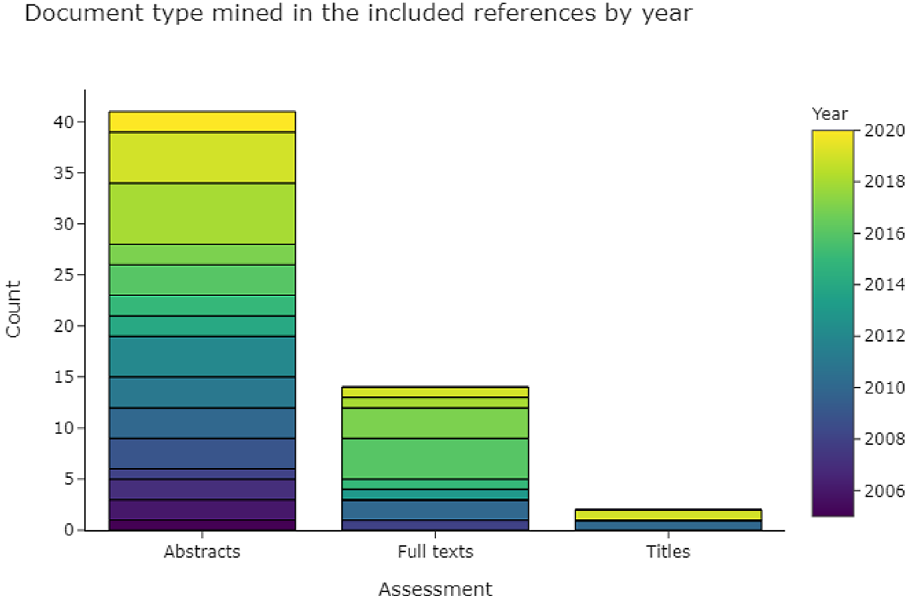
Figure5.Themostcommonassessmentdocumenttypetoconductdataextractionon,asusedintheincluded publications. More than one type per publication is possible, which means that the total number of included publications (n = 53) is lower than the sum of counts of the bars within this figure.